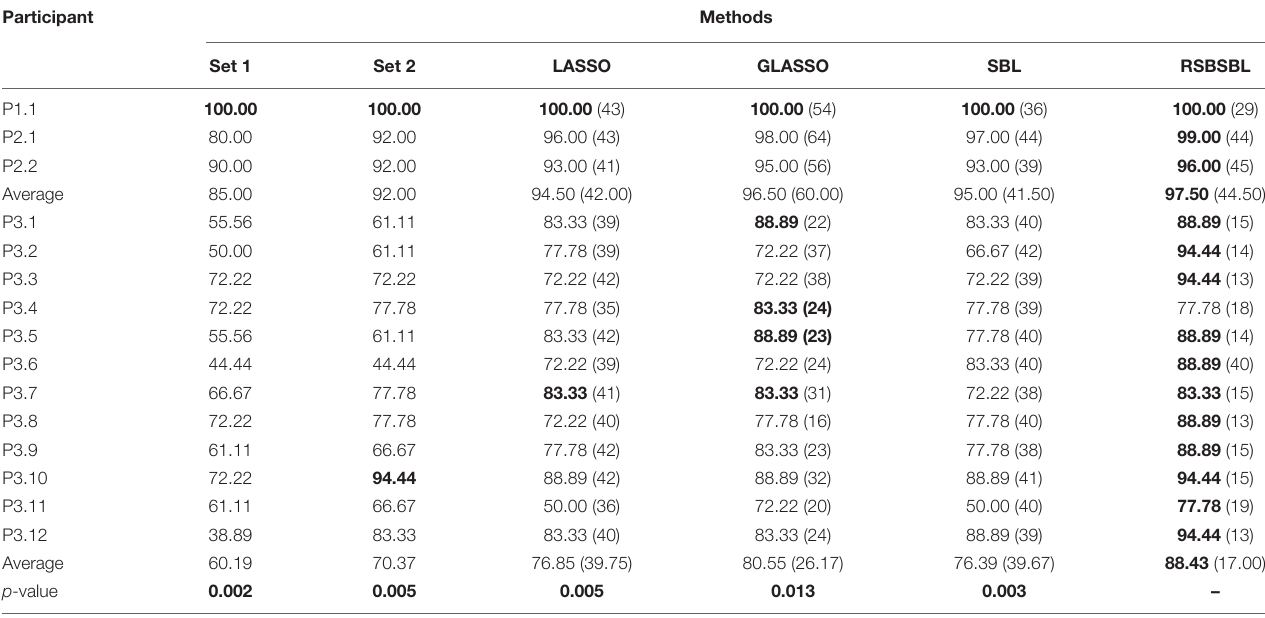
TABLE 2 | Character recognition accuracy (%) (number of channels) and Wilcoxon signed-rank test comparisons for DS1, DS2, and DS3 when each compared method was used for channel selection.